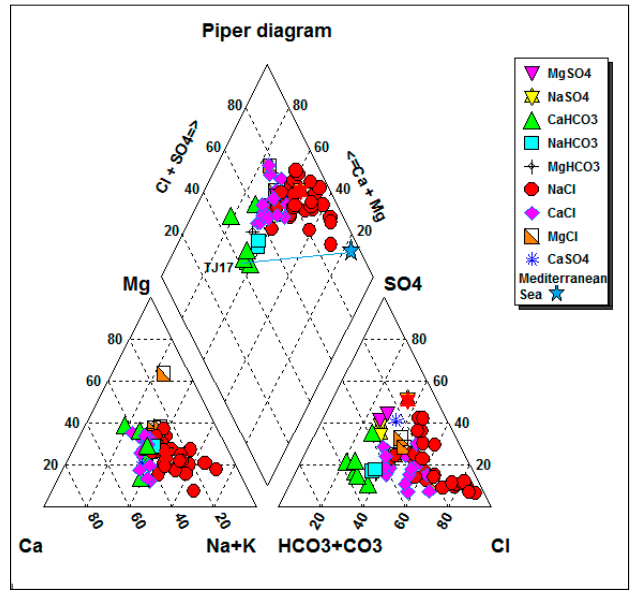
Figure 7. Water types according to Piper diagram.